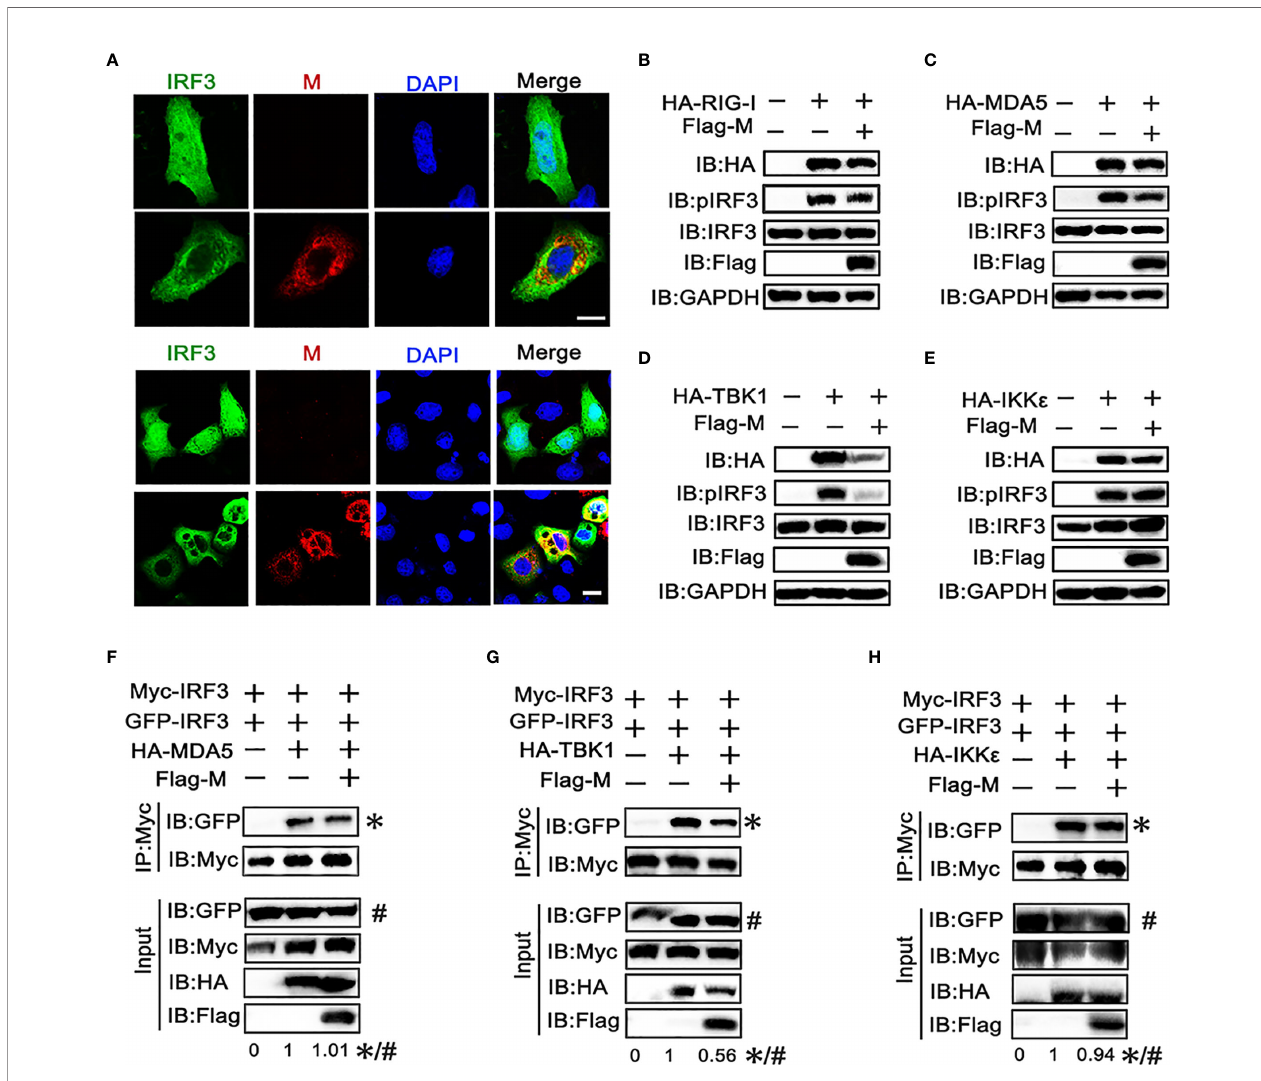
FIGURE 2 | SARS-CoV-2 M inhibits IRF3 nuclear translocation, phosphorylation and dimerization. (A) HEK293T cells were co-transfected with EGFP-tagged IRF3 and a control plasmid or Flag-M expression plasmid. After 24 h, cells were transfected with poly(I:C) for 6 h, and were immuno ‐ stained with anti ‐ Flag antibody (red) and counterstained with DAPI to examine chromosomes (blue). Green: IRF3 signal; Red: SARS-2-CoV-2 M signal; Blue: DAPI (nuclei signal). (B – E) HEK293T cells were transfected with Flag-M together with HA-tagged RIG-I (B) , MDA5 (C) , TBK1 (D) , or IKK ϵ (E) , which was applied to activate IRF3. Proteins were extracted 24 h after transfection. The indicated proteins were analyzed by immunoblot. GAPDH was detected as a loading control. (F – H) HEK293T cells were transfected with GFP- IRF3, Myc-IRF3, and Flag-M together with HA-tagged MDA5 (F) , TBK1 (G) , or IKK ϵ (H) , which was applied to activate IRF3 dimerization. Proteins were extracted 30 h after transfection. The cell lysates were immunoprecipitated with anti-Myc antibody. The cell lysates and the immunoprecipitants were analyzed by immunoblot. The relative band intensity (*/#) of co-immunoprecipitated IRF3 in (F – H) was measured using ImageJ